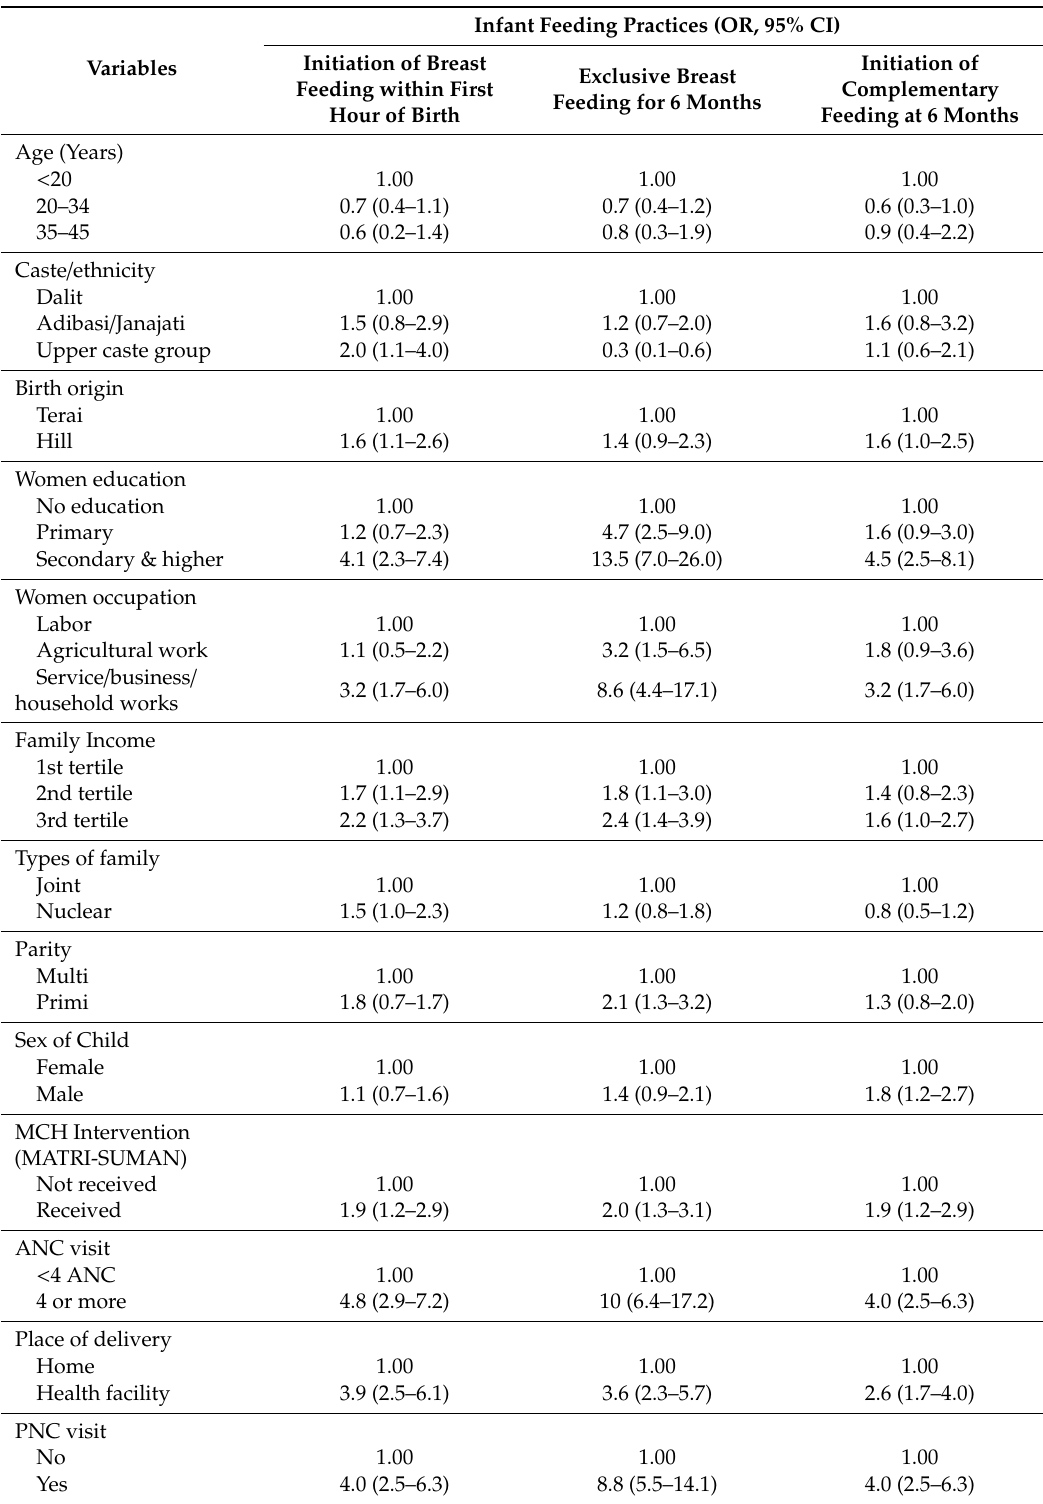
Table 4. Maternal factors and utilization of maternal care services associated with infant feeding practice in rural Southern Nepal, 2016 by Unadjusted Odds Ratio (OR). Infant Feeding Practices (OR, 95% CI) Initiation of Breast Initiation of Variables Exclusive Breast Feeding within First Complementary Feeding for 6 Months Hour of Birth Feeding at 6